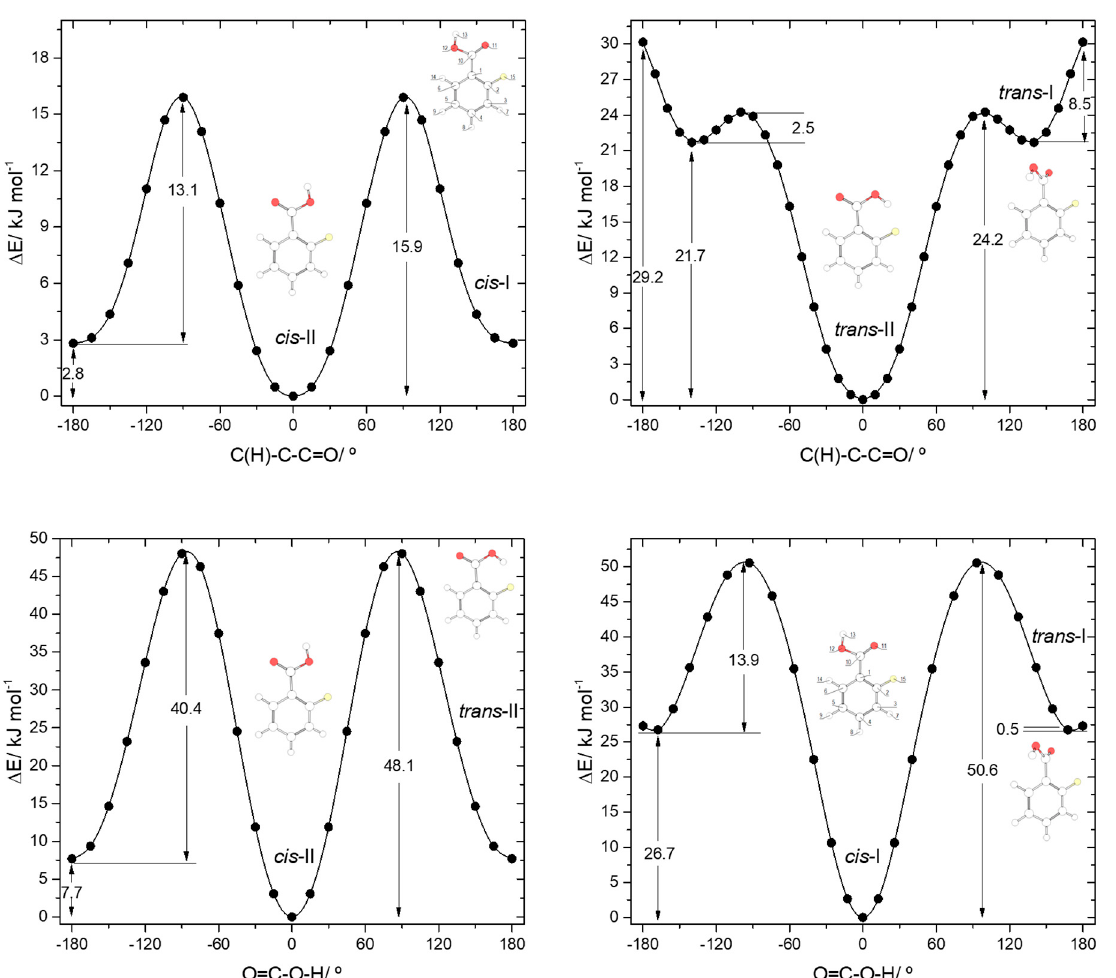
Figure 4. B3LYP / 6-311 ++ G(d,p) calculated potential energy profiles for internal rotation about the exocyclic C-C (for cis and trans arrangement of the carboxylic group) ( top left and top right panels ) and about the C-O bond (connecting the two pairs of conformers, cis -II / trans -II and cis -I / trans -I; bottom left and bottom right panels ) for 2-fluorobenzoic acid.